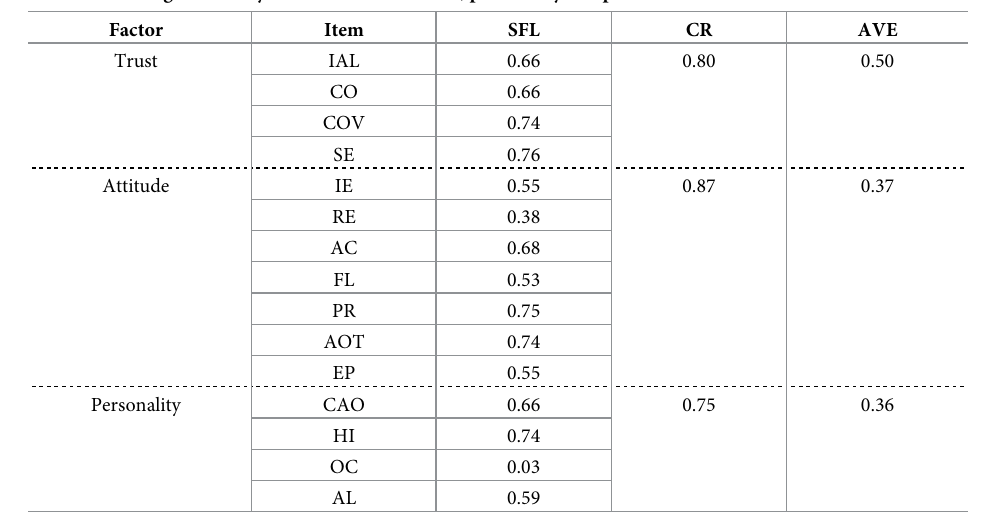
Table 5. Convergent validity of measures of attitude, personality and